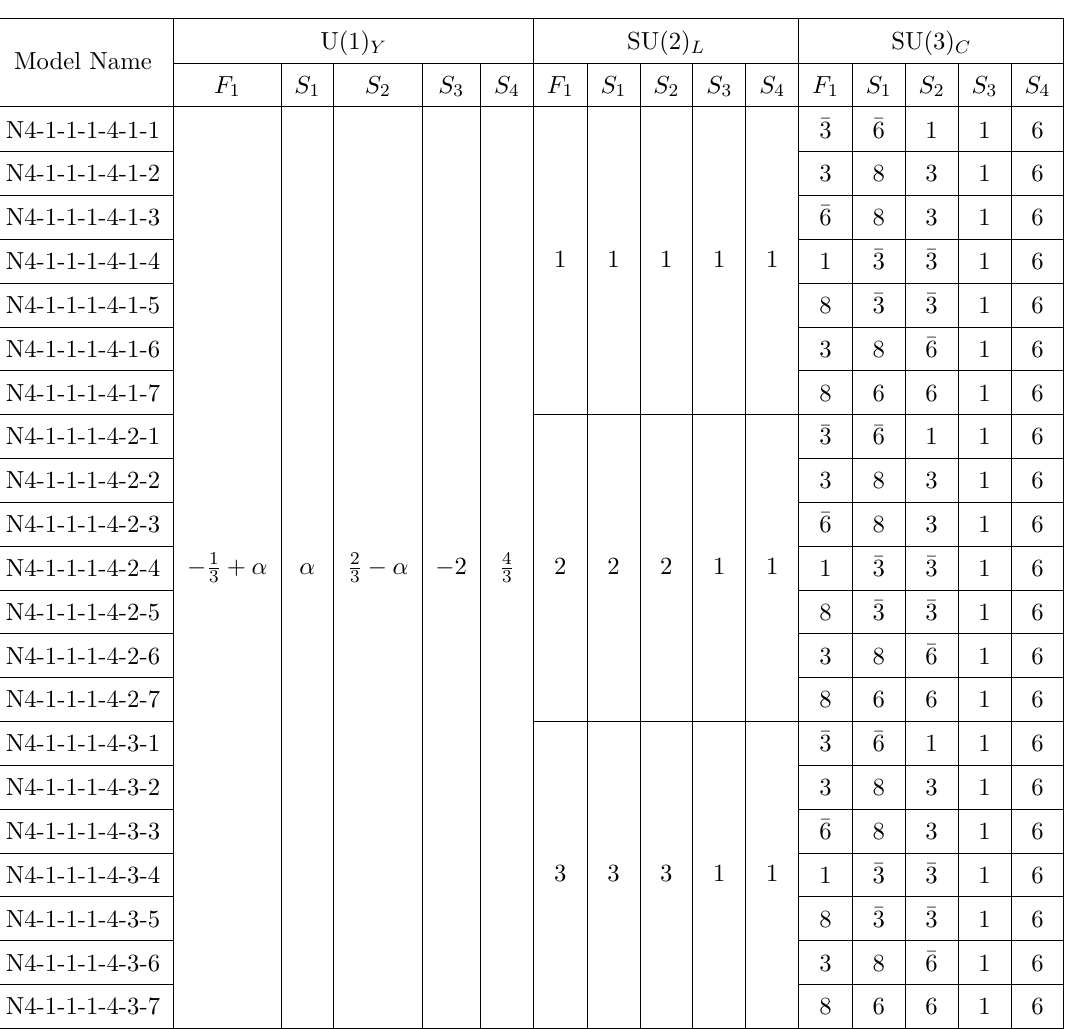
Table 9 . The one-loop models for the 0 νββ decay operator N4 arising from the diagram N4-1-1-1-4 shown in figure